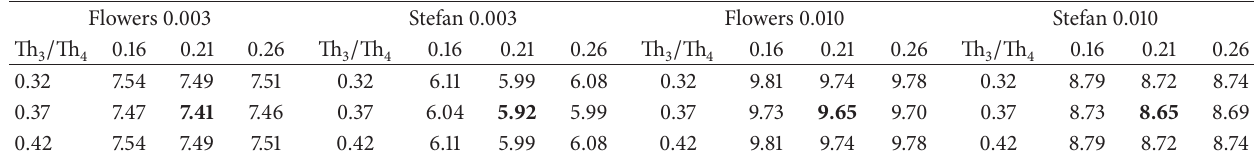
Table 3: MAE values (dB) for threshold parameters Th 3 / Th 4 .